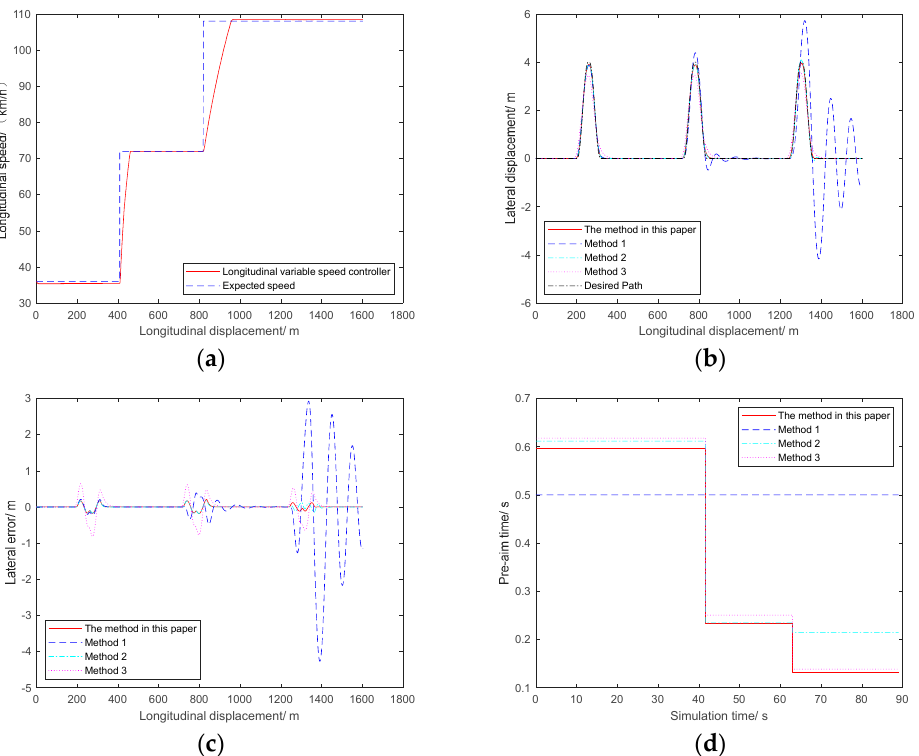
Figure 7. Variable ‐ speed continuous ‐ curve simulation results: ( a ) Longitudinal speed change curve of the vehicle. ( b ) Path tracking with different methods. ( c ) Lateral displacement tracking deviation. ( d ) Adaptive change in pre ‐ aim time.